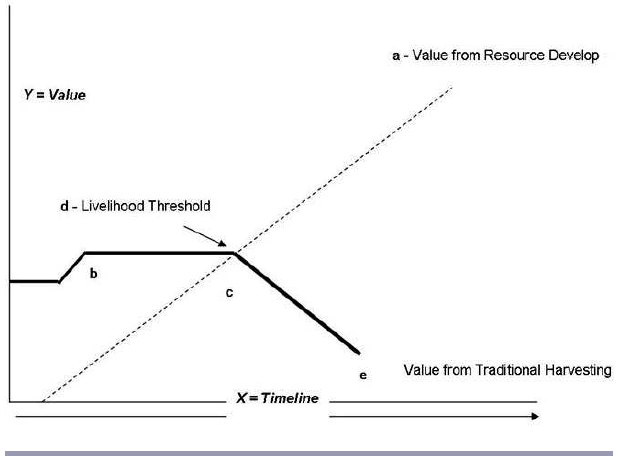
Fig. 4. Social-ecological thresholds of Cree livelihood in the context of increasing resource development. The total value from land use, whether resource development or traditional harvesting, in the Treaty #8 region is represented on the y axis. A conceptual timeline is shown on the x axis. (a) Since the signing of Treaty #8 in 1899, lands have increasingly been alienated away from traditional uses of hunting, fishing, trapping, and related harvesting activities and have been “taken up” (as described in the language of the Treaty) for other uses defined by the state. The heuristic suggests that traditional land use patterns may have been relatively noncompetitive with resource development during the early period of settlement (b-c). However, the capacity of harvesters to sustain such a traditional livelihood was inevitably surpassed (d) with increased development and impacts on resource availability (RAV), which is defined here as a function of resource quality (RQ), physical and institutional access (RAC), with feedbacks on the capacity, i.e., knowledge and skills, for resource harvesting (CRH;